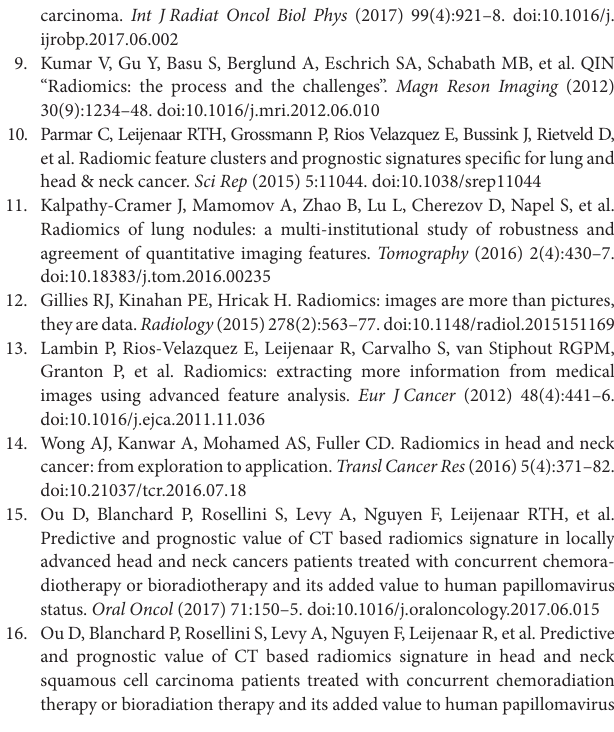
taBLe S1 | Blank checklist. taBLe S2 | Finalized checklist scores. taBLe S3 | MRI radiomics in HNC: abstracts only. taBLe S4 | Reports of measured outcomes. taBLe S5 | Search